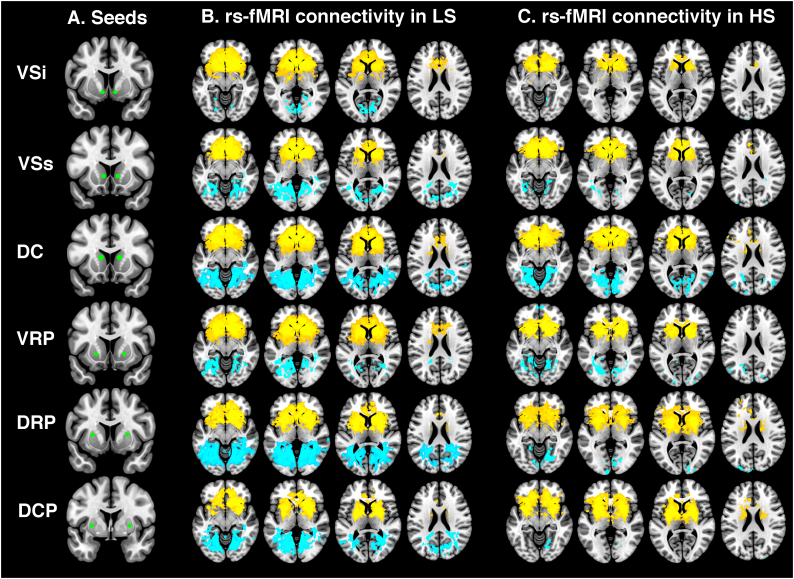
(A) Location of striatal seed regions (green). Within-group functional connectivity maps between each striatal seed region and the whole brain in (B) LS subjects and (C) HS subjects. Blue refers to negative coupling, yellow refers to positive coupling. Maps thresholded at p < .001 uncorrected for display purposes. DC, dorsal caudate; DCP, dorsocaudal putamen; DRP, dorsorostral putamen; VRP, ventrorostral putamen; VSi, ventral caudate inferior; VSs, ventral caudate superior.